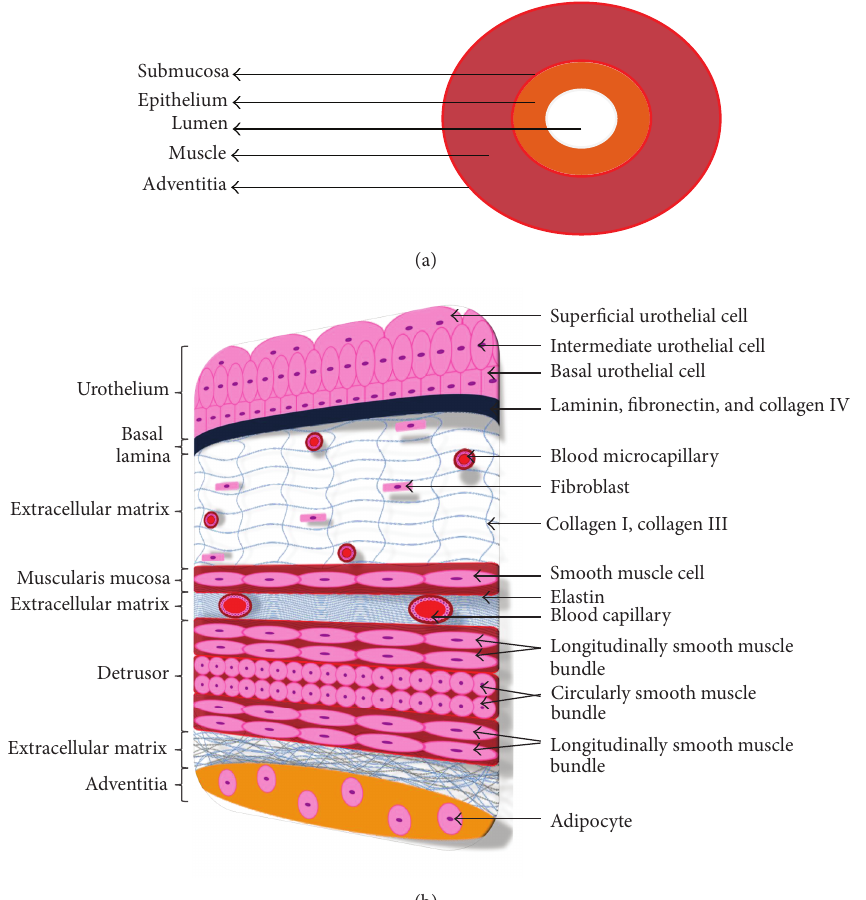
Figure 1: (a) Diagram for general architecture and cell layers of urinary bladder and urethra. (b) Diagram for the histology of the urinary